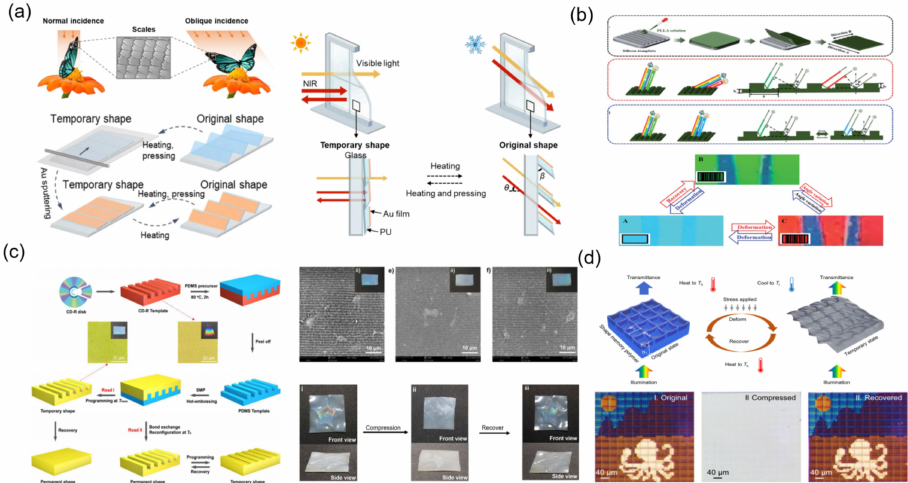
Figure 9. The strategy of thermal driving mode of mechanoresponsive smart windows: ( a ) formation of surface wrinkled structure [58] Copyright 2022, American Chemical Society, ( b ) formation of dynamic network structure [59] Copyright 2022, Royal Society Chemistry (London, UK), ( c ) formation of nanostripe structure [60] Copyright 2022, Elsevier, ( d ) formation of shape memory polymer grids [61], Copyright 2021, Springer